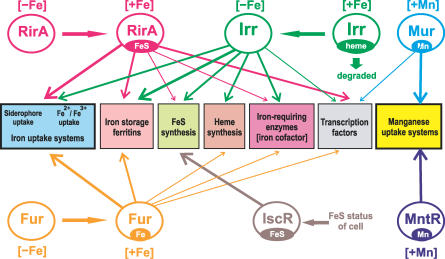
Combined Regulatory Network for Iron and Manganese Homeostasis Genes in α-ProteobacteriaThe connecting lines denote regulatory interactions, with the thickness reflecting the frequency of the interaction in the analyzed genomes.